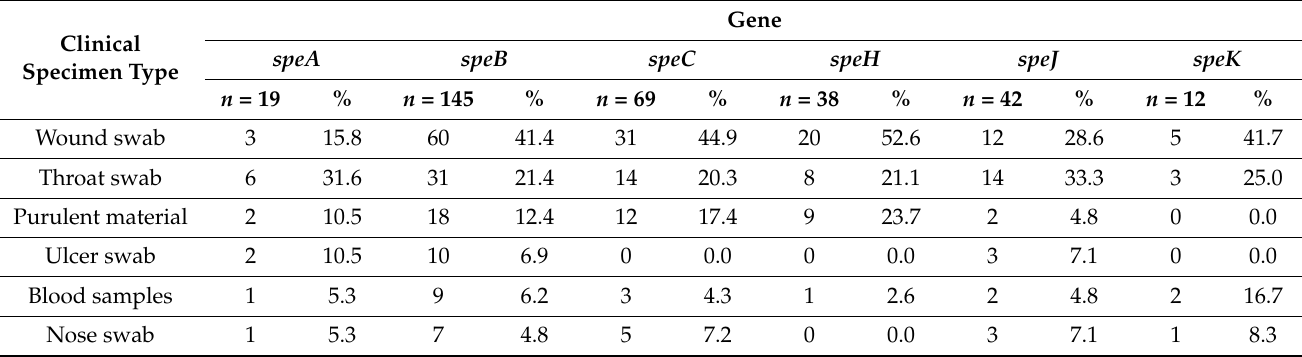
Table 2. Occurrence of the virulence factor genes with respect to the origin of S. pyogenes strains from selected types of clinical material.